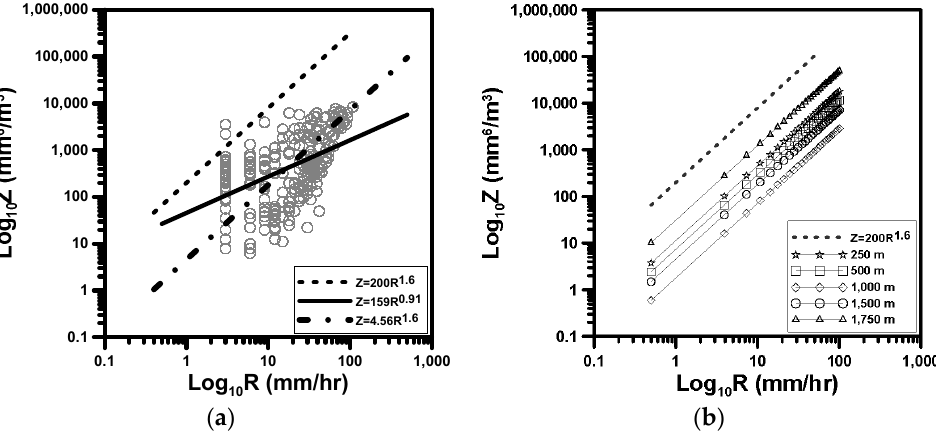
Figure 6. Z-R relations determined for the altitude zone 1250–1500 m as an example ( a ), and those determined for each altitude zone ( b ). (In Figure 6a Z = 200R 1.6 represents the Z-R relation proposed by Marshall and Palmer (1948), Z = 159R 0.91 the regression equation derived simply by applying the least square method, and Z = 4.56R 1.6 the one derived after fixing the exponent b to be 1.6).